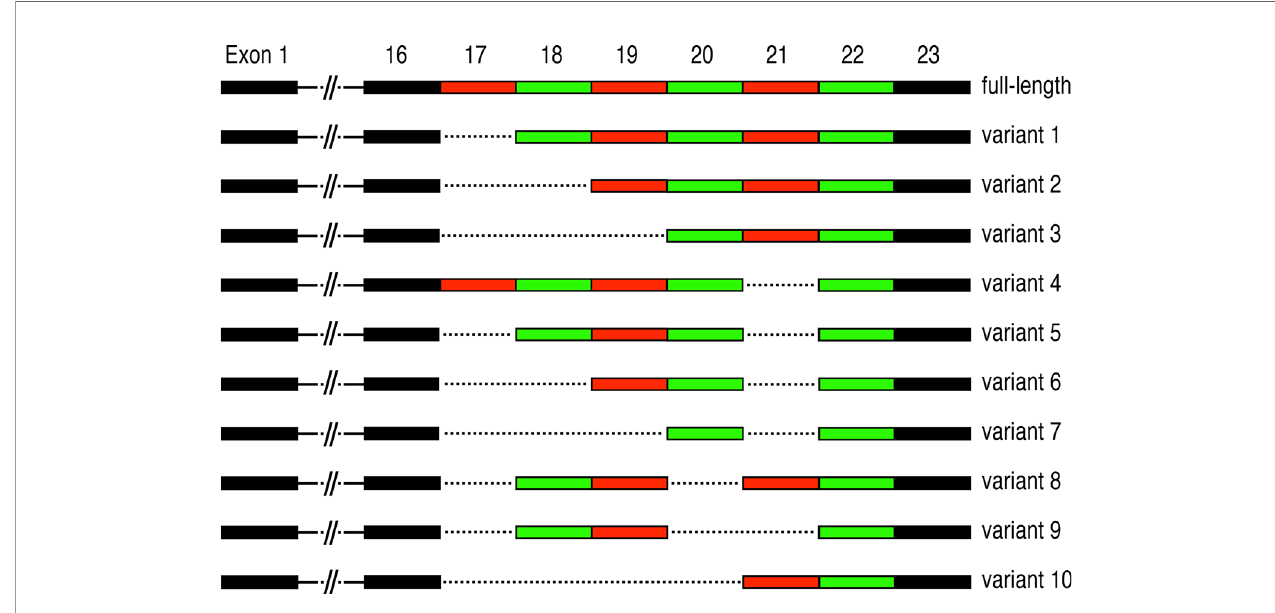
FIGURE 3 | Periostin alternative splicing: Alternative splicing events occurring in the C-terminal region of periostin. Exons 17-22 are multiples of three nucleotides and are ranging from 90 (exons 18, 19), 84 (exon 21), 81 (exon 17), 78 (exon 20) to 42 (exon 22) nucleotides. Alternative splicing in this domain is likely to in fl uence the binding abilities to different HSPGs and thus ECM dynamics and structure during in fl ammation, fi brosis and